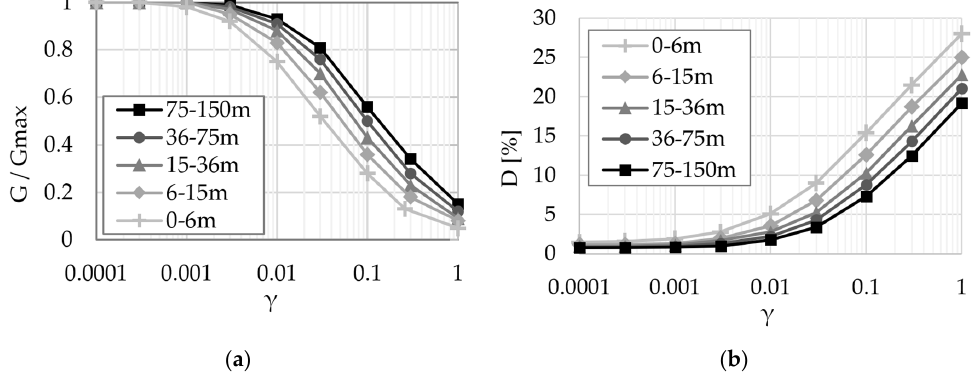
Figure 8. G- γ and D- γ curves for sand and gravel according to ASCE 4-16; ( a ) G- γ ; ( b ) D- γ [50]. The usual vertical-propagating wave field is used as follows: SV-waves for the lon- gitudinal direction (X), SH-waves for the transverse direction (Y) and P-waves for the ver- tical direction (Z). The seismic waves propagate through the free-field soil layers until they reach the surface, which may produce significant changes in the ground motion that actually loads the structure.